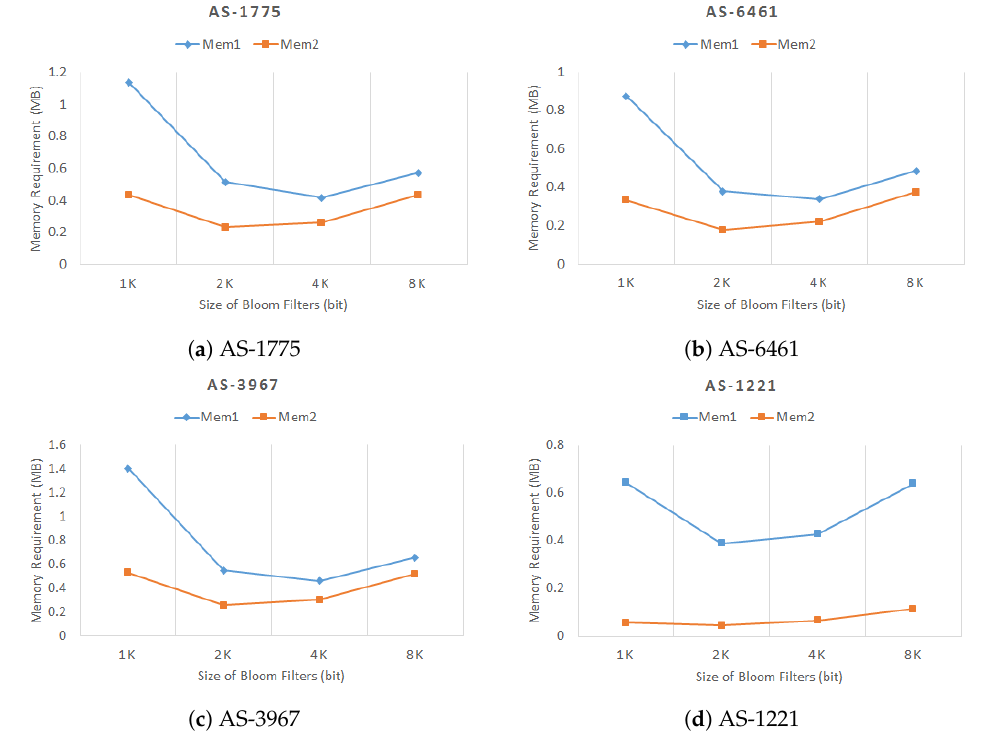
Figure 8. Memory requirements based on Equation (4) and (5). As the size of the Bloom filter grows, the memory requirement for the Bloom filter naturally increases, but the number of auxiliary FIB entries decreases. In all topologies, the memory usages are minimal when the size of the Bloom filter is 2048